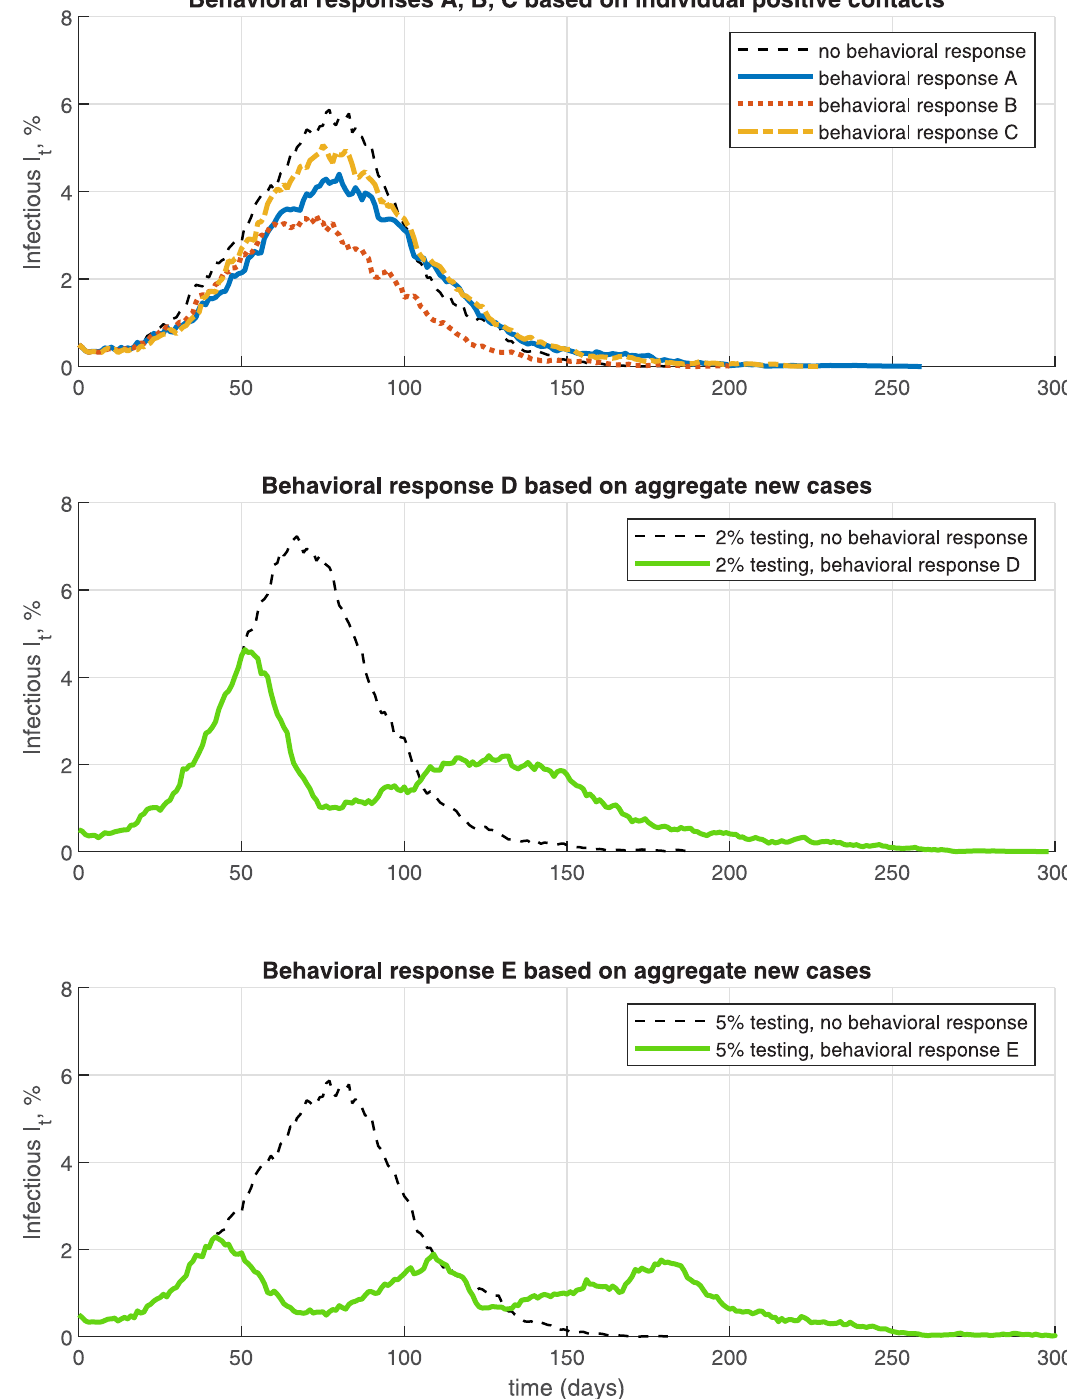
Fig 10. Behavioral responses—endogenous distancing and relaxation.